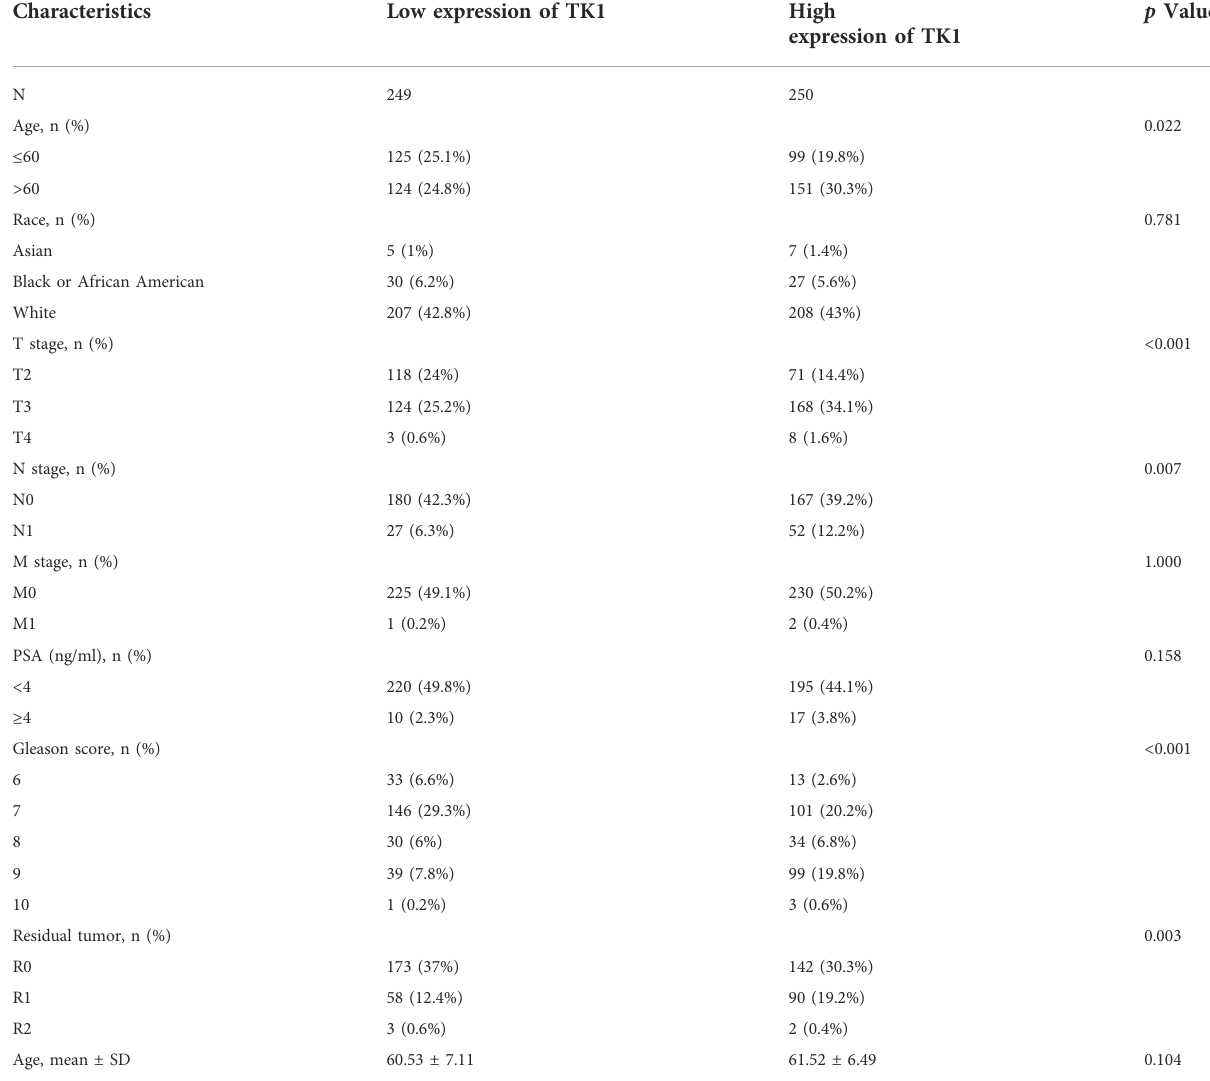
TABLE 1 Relationship between TK1 expression and clinicopathological features in patients with PCa.